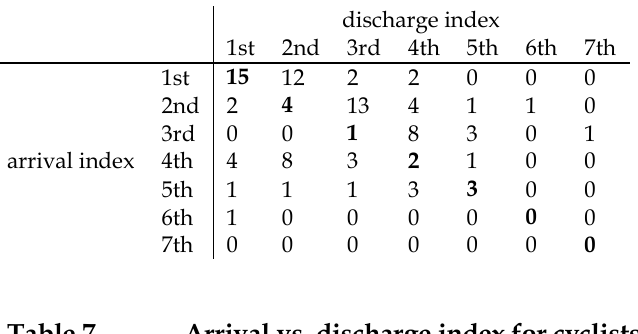
Arrival vs. discharge index for cyclists in the second and third channel